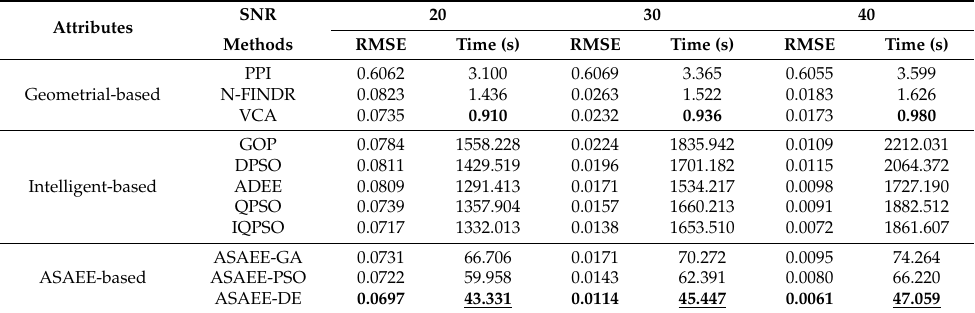
Table 1. Comparison of the proposed ASAEE framework with other algorithms on DS1.